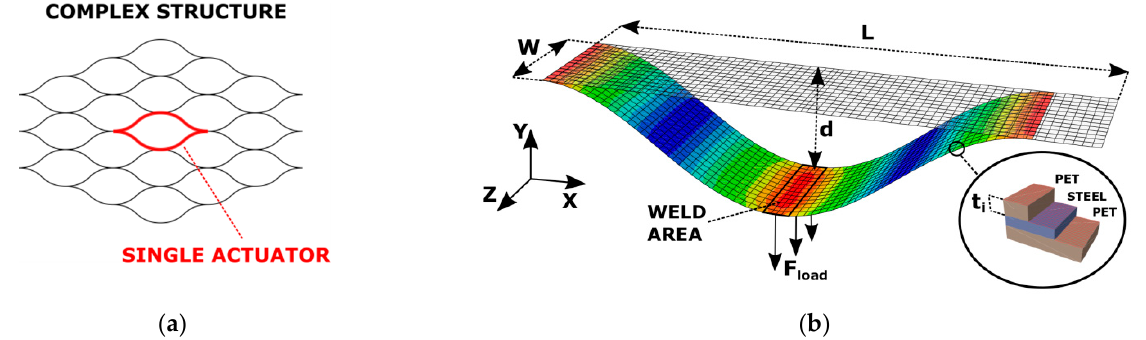
Figure 1. ( a ) Complex structure of an artificial muscle; ( b ) FEM model of half of a single actuator considered in the research.